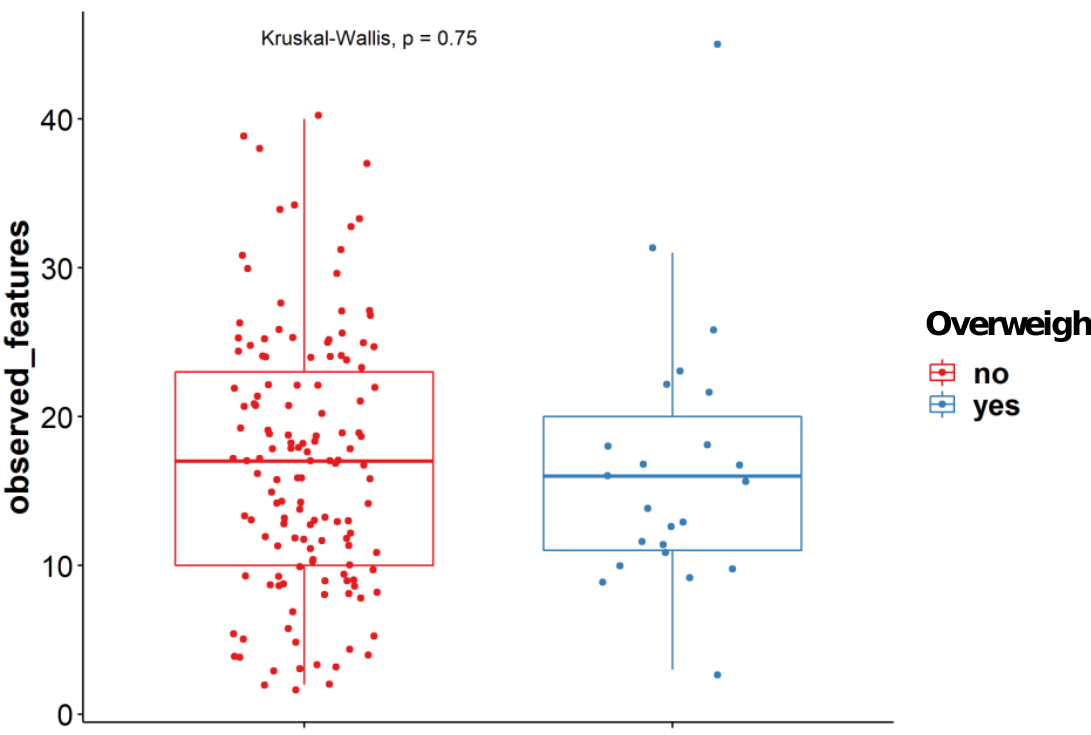
Figure 2. Observed features at ASV levels for overweight (n = 23) and non-overweight (n = 140) subjects (Kruskal-Wallis test).